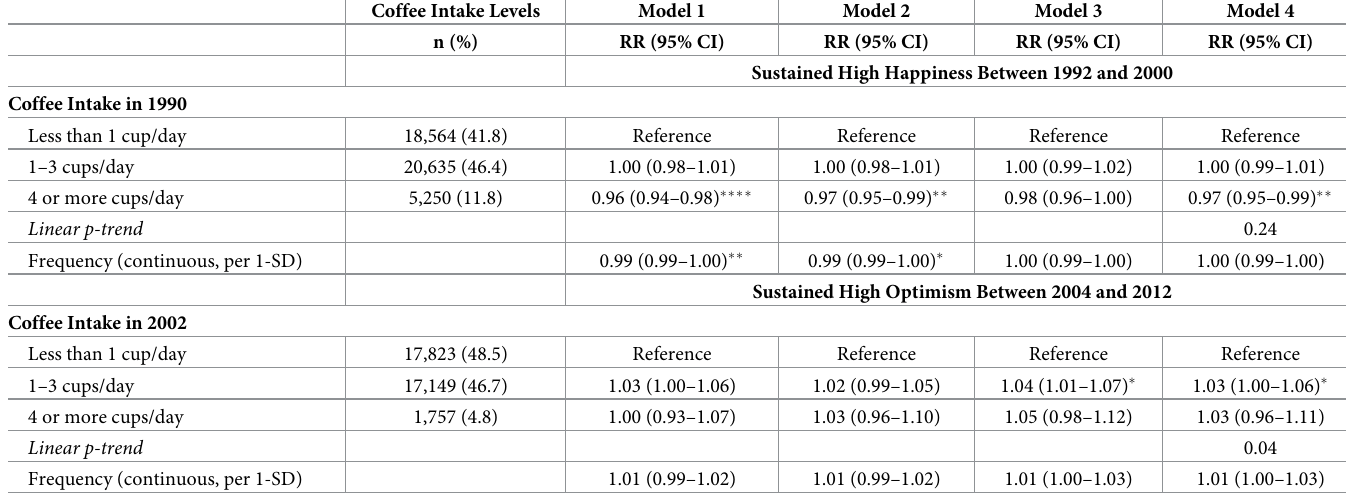
Table 2. Generalized estimating equations with a Poisson distribution evaluating the association of baseline coffee intake with likelihood of reporting sustained high levels of happiness (N = 44,449) and optimism (N = 36,729) a,b